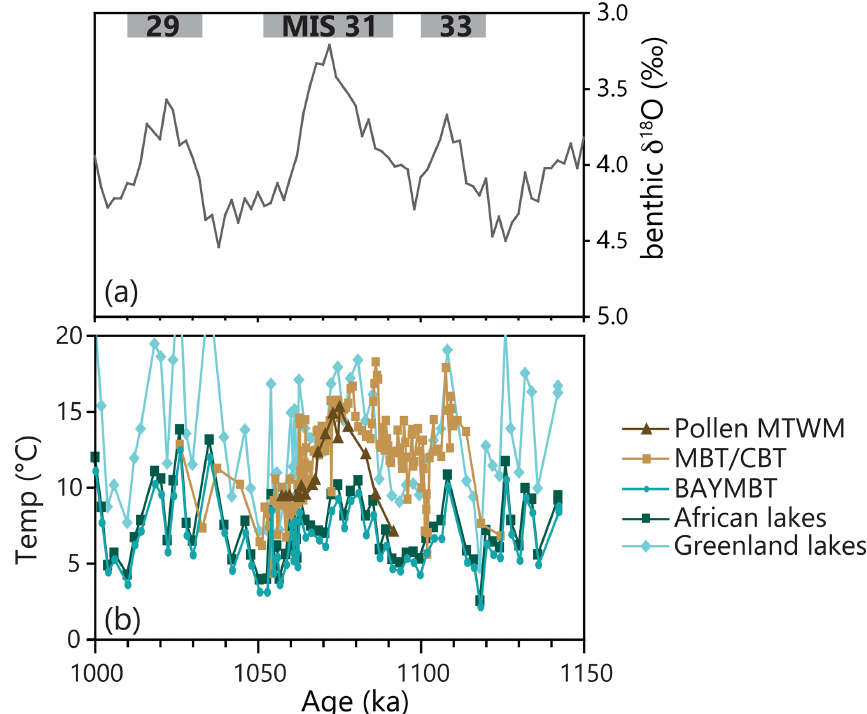
Figure 5. Comparison of brGDGT calibration during MIS 31 with pollen-derived temperature estimates (Melles et al., 2012). (a) The global benthic oxygen isotope stack (Lisiecki and Raymo, 2005) with the different Marine Isotope Stage (MIS) is indicated at the top for reference. (b) Lake El’gygytgyn brGDGT temperature estimates using the calibrations of Zhao et al. (2021) based on Greenland lakes, the African lakes MBT (cid:48) calibration of Russell et al. (2018), the MBT/CBT calibration of Sun et al. (2011) (this is the previously published dataset from 5ME de Wet et al., 2016), the BayMBT calibration (Martínez-Sosa et al., 2021), and pollen mean temperature of the warmest month (MTWM) from Melles et al. (2012). Additional brGDGT calibrations are shown in Fig. S8. Note how the BayMBT and African lakes calibrations yield similar results and nearly plot on top of each